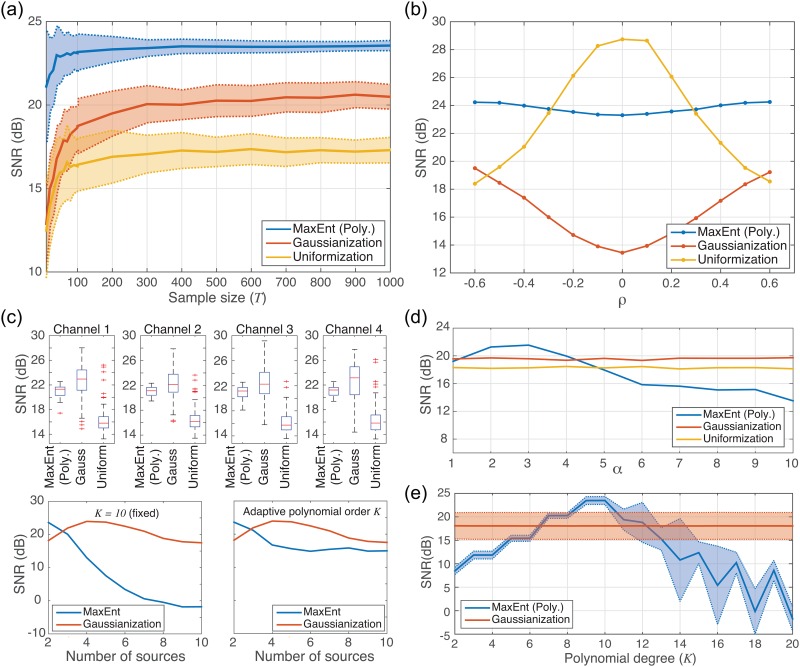
Experimental results with MaxEnt algorithm with polynomial (Poly.) and neural network (N.N.) parameterizations, Gaussianization and Uniformization methods, for different scenarios over a set of 100 experiments: (a) Mean ± std SNR evolution (channel 1) when the number of samples T changes from 10 to 1000 for a fixed random matrix A. (b) Mean SNR evolution (channel 1) when the 2 × 2 mixing matrix A changes according to parameter ρ as in eq (14). (c) Top: Boxplot of SNR for each channel with a fixed 4 × 4 random mixing matrix. Bottom: SNR as a function of the number of mixing sources for a fixed polynomial order K = 10 (left) and for adaptively chosen polynomial order K. (d) Mean SNR versus nonlinearity parameter α as in eq (15). (e) Mean ± std SNR of MaxEnt (Poly.) as a function of the polynomial degree (K) compared against the SNRs obtained with the Gaussianization algorithm.